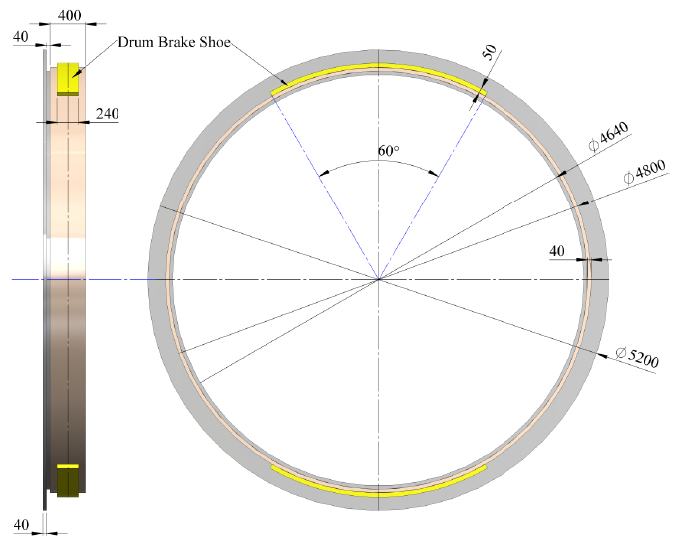
Figure 5. Drum-and-shoe configuration with drum, shoes and contact surface positioning and dimensions. (Unit: mm).